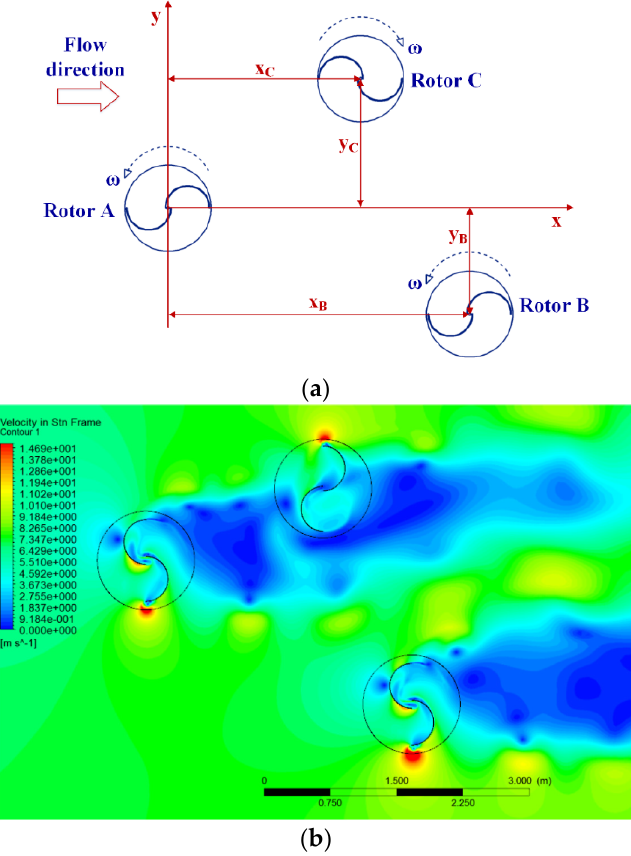
Figure 11. Scheme of three rotors and flow characteristic [41]. ( a ) Schematic view of the three-rotor configuration; ( b ) Velocity distribution near the three rotors.